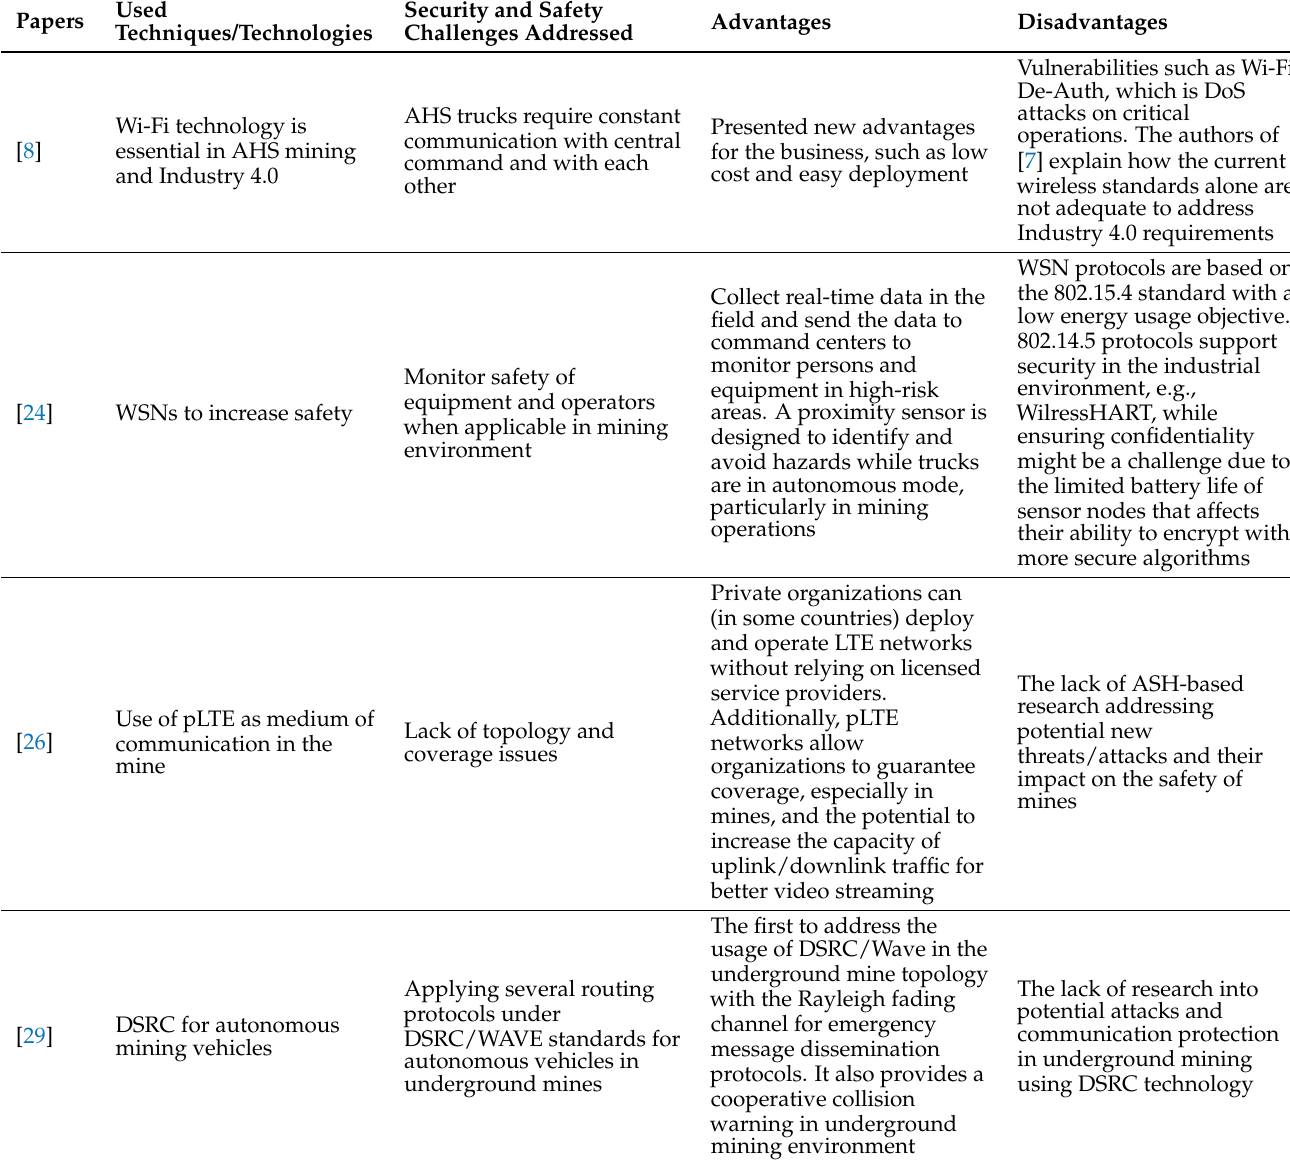
Table 2. Summary of literature on cybersecurity and